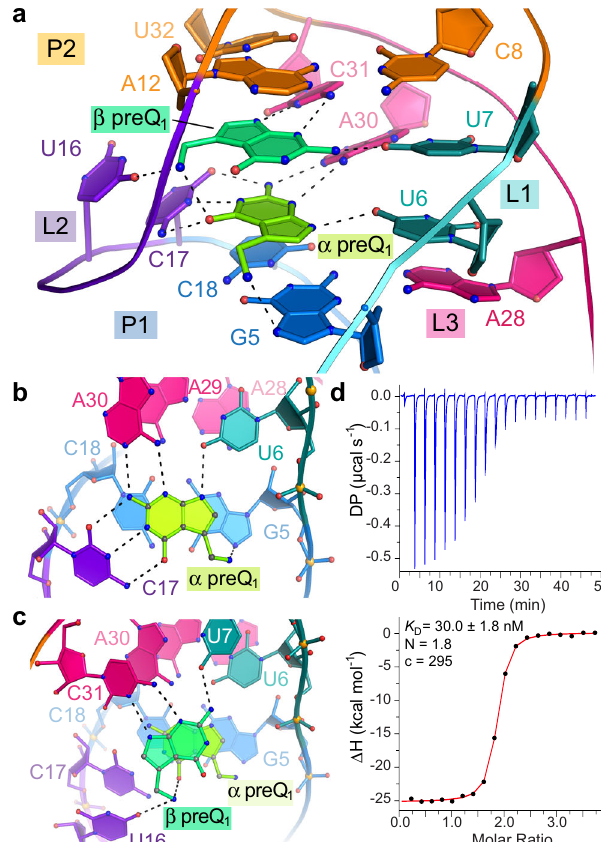
Fig. 2 The Can preQ 1 -I I riboswitch pocket with two preQ 1 ligands and con fi rmation of ligand-to-RNA stoichiometry. a Overview of fully occupied binding pocket. Interactions in the ( b ) α site and ( c ) β site.